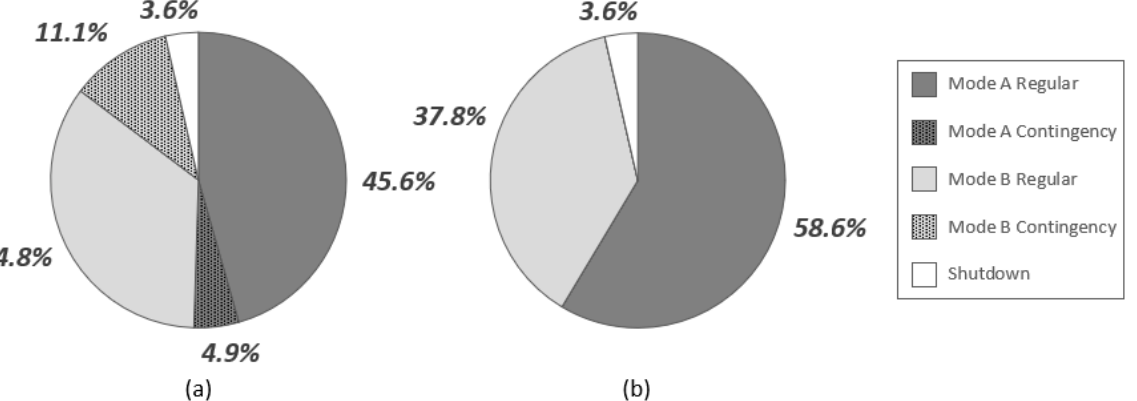
Figure 11. Time-averaged distribution of operational modes in response to geological uncertainty in the context of Canada’s oil sands, for ( a ) naïve framework using the deterministic critical ore 2 threshold of 2.916 Mt and target total stockpile level of 4.374 Mt; ( b ) enhanced configuration using a critical value of 7.290 Mt (2.5×) and target total stockpile level of 14.580 Mt.